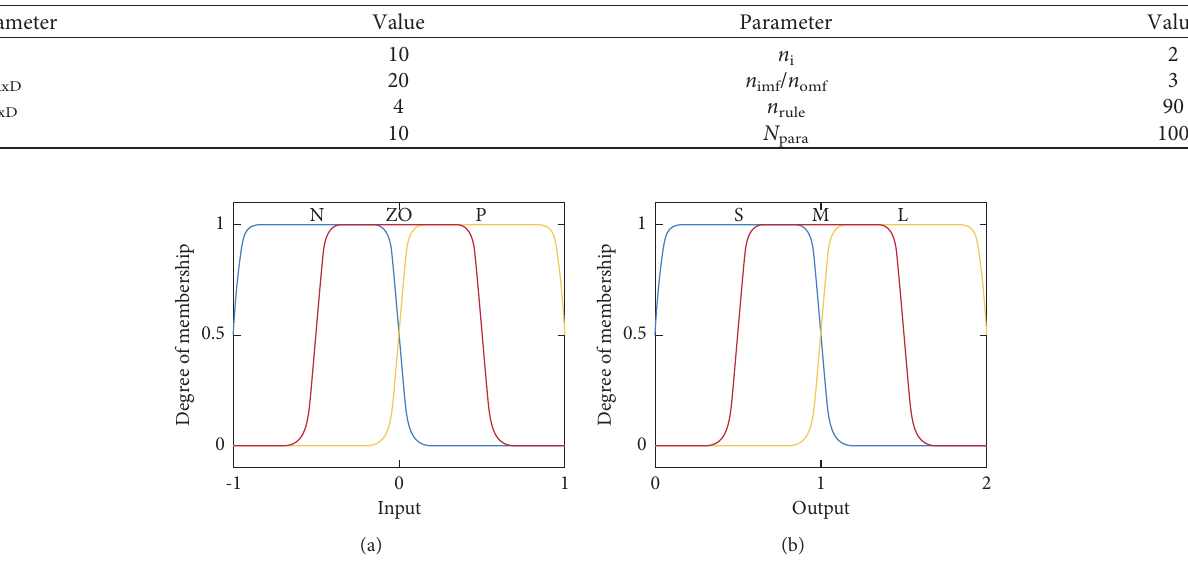
Figure 3: Membership functions (MFs): (a) input MFs and (b) output MFs.